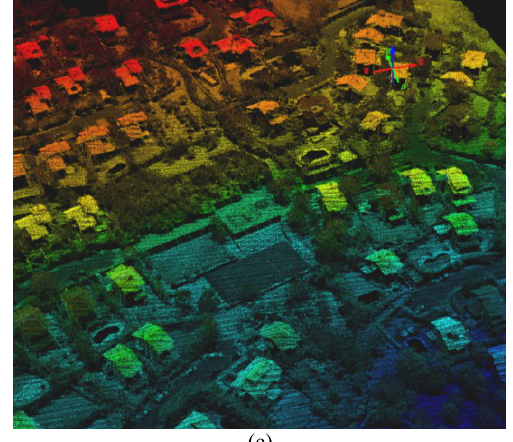
Figure 3. The generated DSM with UltraMap V3.1 (a), DLR software (b) and reference LiDAR point cloud (c)